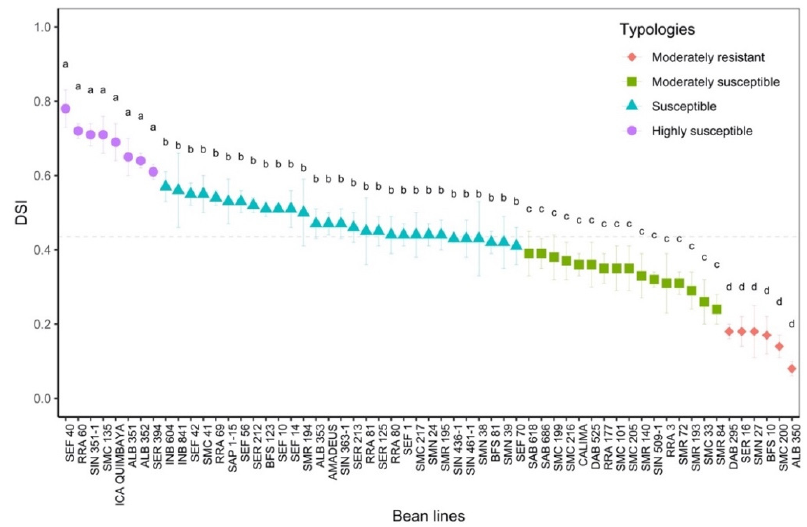
Figure 4. Disease susceptibility index (DSI) of advanced bean lines. The dashed black line corresponds to the mean of each variable. a, b, c, d: Letters at each point for each common bean forward line indicate statistically significant differences based on the LSD means test ( p < 0.05). Results include the mean ± SE (n = 708).